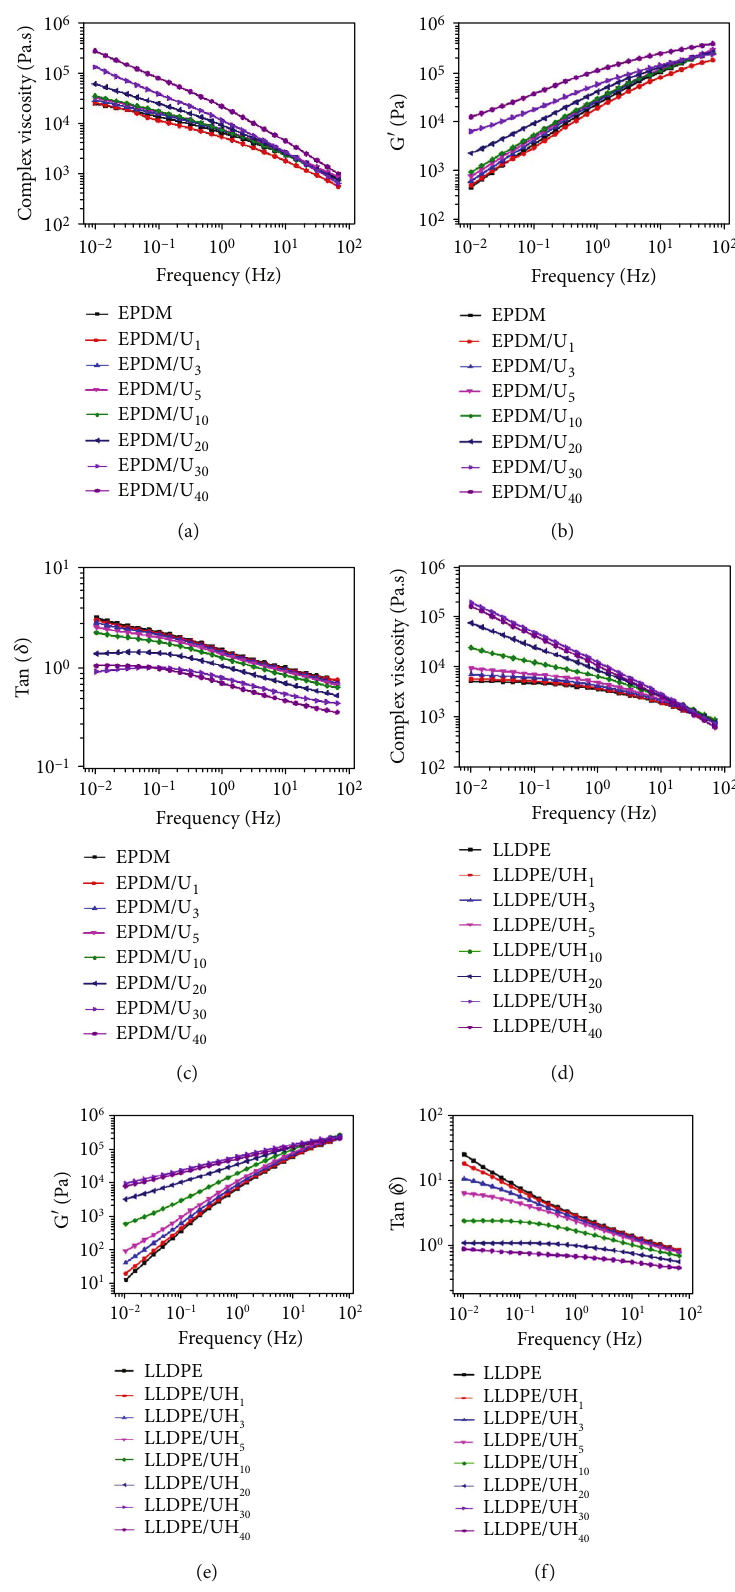
Figure 5: (a, d) Complex viscosity versus frequency at 190 ° C for EPDM/U and LLDPE/U. (b, e) Storage modulus versus frequency at 190 ° C for EPDM/U and LLDPE/U. (c, f) Tan δ as functions of frequency at 190 ° C for EPDM/U and